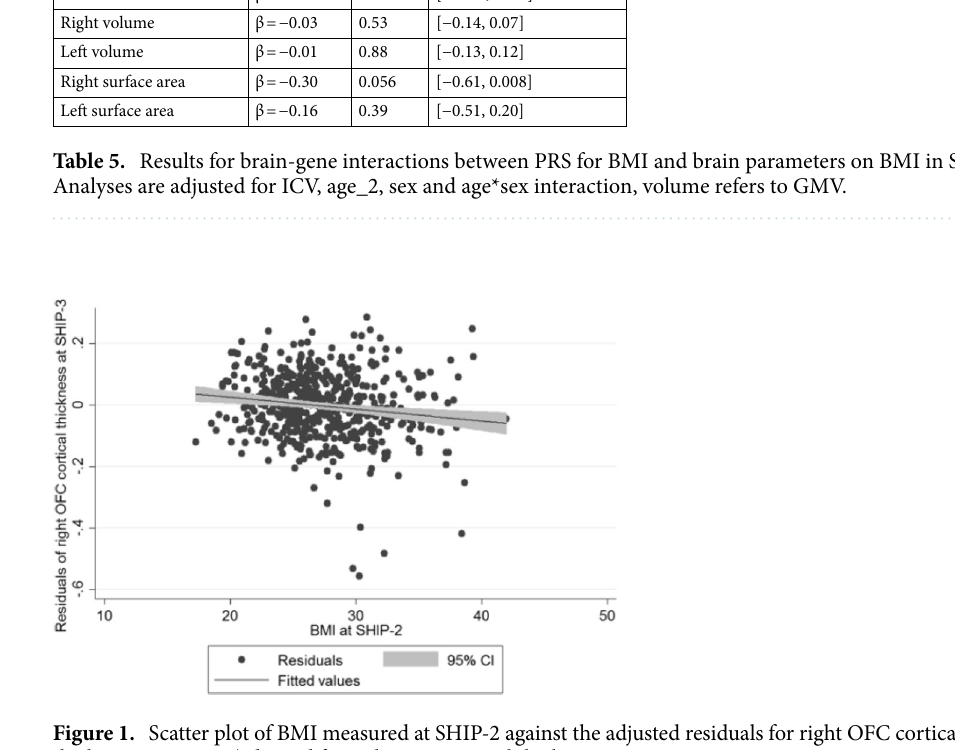
Figure 1. Scatter plot of BMI measured at SHIP-2 against the adjusted residuals for right OFC cortical thickness at SHIP-3 (adjusted for right OFC cortical thickness at SHIP-2, age, sex, age*sex interaction, ICV, follow-up